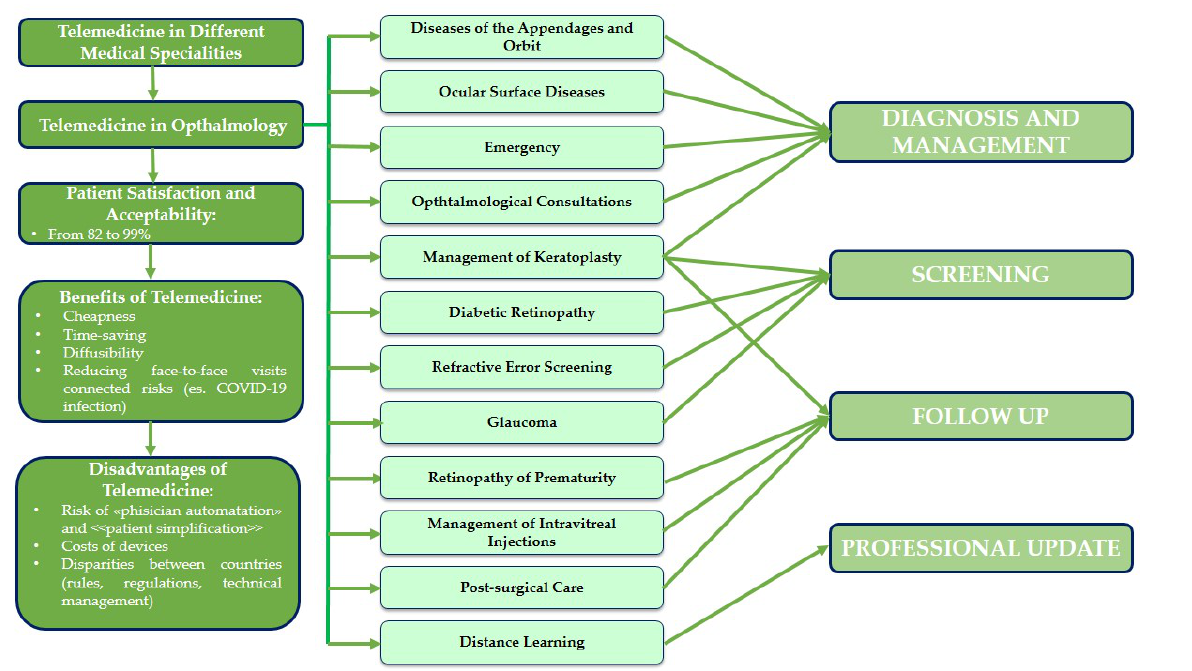
Figure 1. Flow chart. The figure analyzes the first part of review concerning all ophthalmological applications of